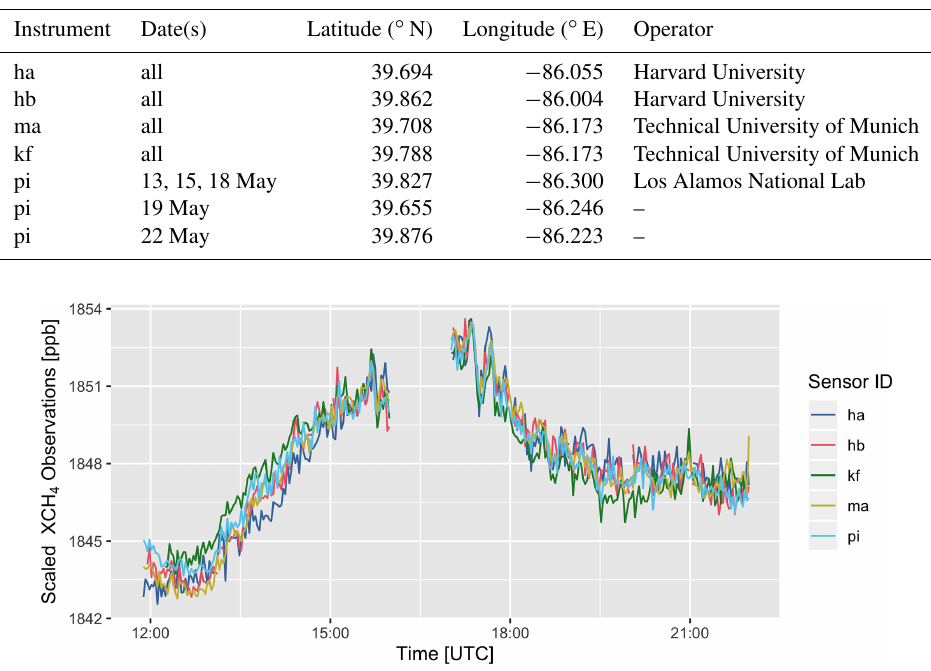
Table 2. Location of EM27/SUNs on each day of the campaign. All instruments were operated at ground level, except for hb, which was on top of a 20m building.